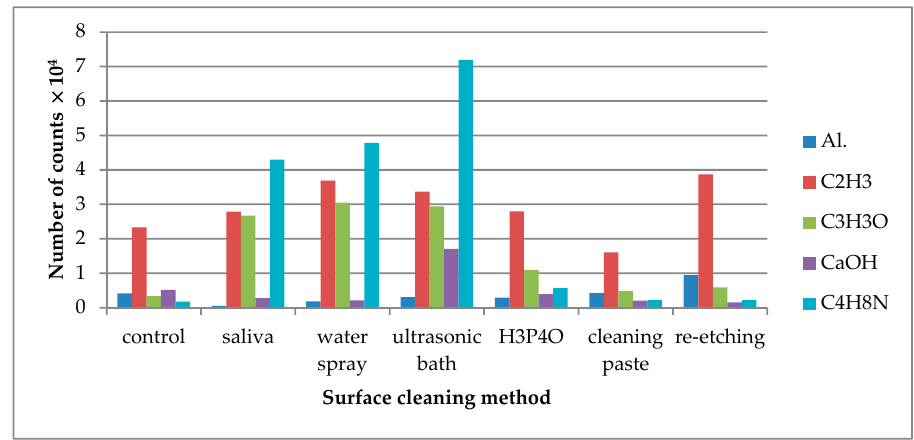
Figure 1. Number of counts of positive ions emitted from the surface of leucite glass ceramic (LGC) after various surface cleaning methods.